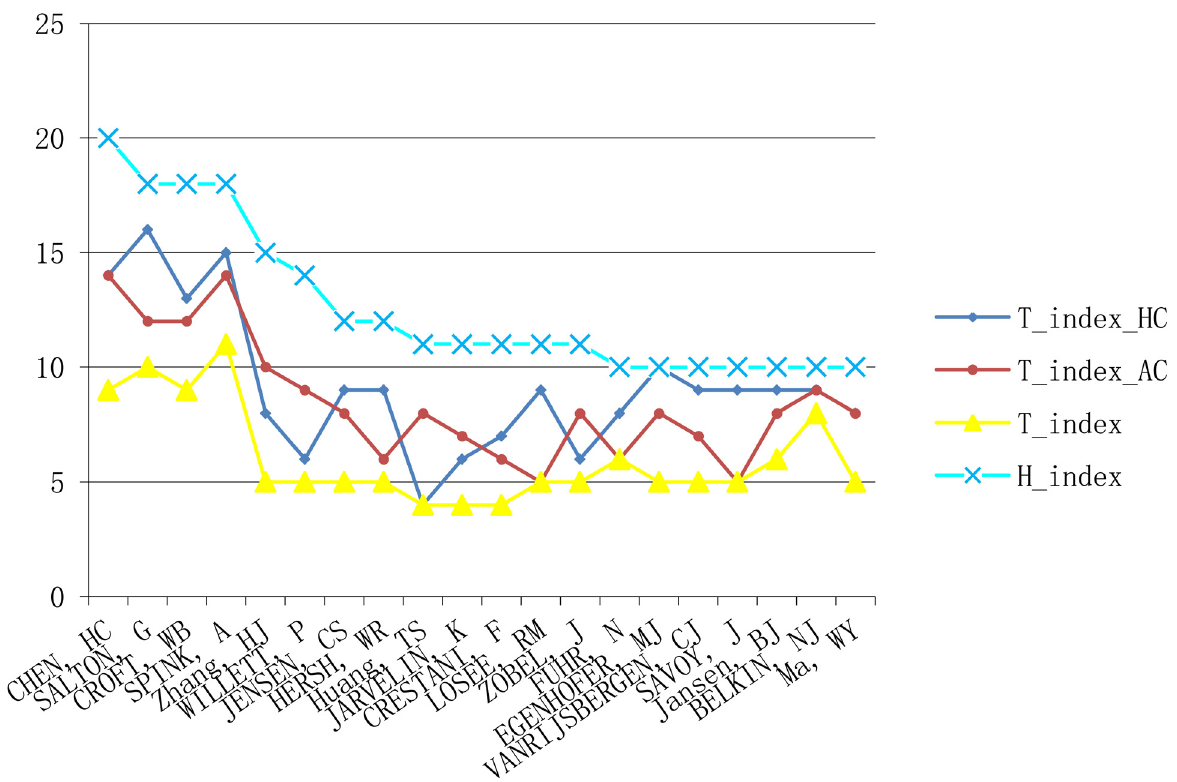
Fig 2. The comparison between values of t_index and